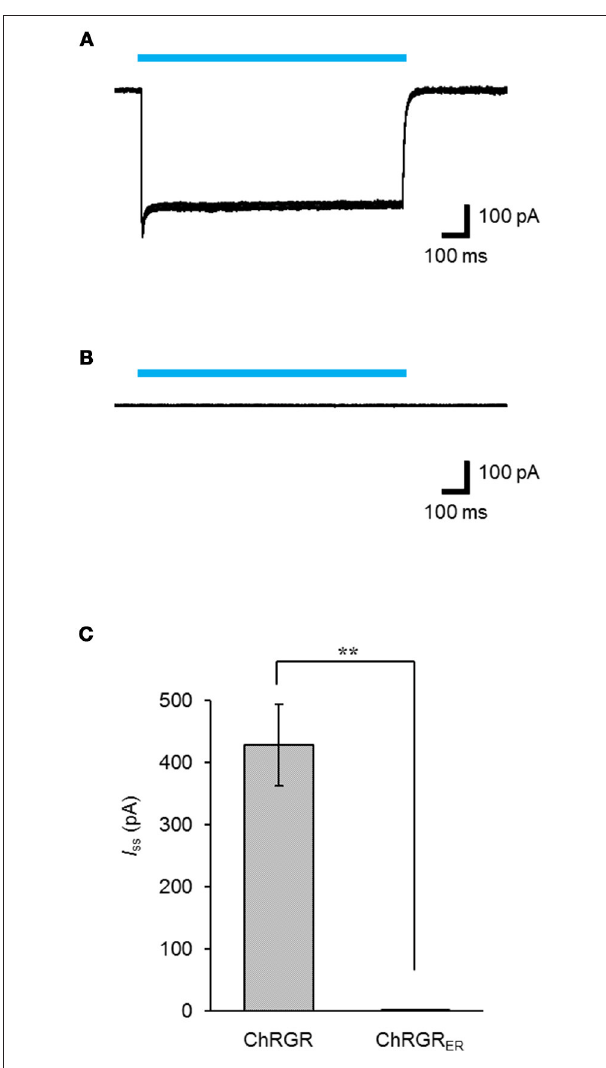
FIGURE 3 | Intracellular distribution of ChRGR ER . (A,B) Overlay of sample photocurrents recorded from either a ChRGR-expressing C2C12 cell (A) or ChRGR ER -expressing one (B) . Each cyan line shows the timing of the LED irradiation (505 ± 15nm, 1.6 mWmm − 2 ). (C) Summary of the I ss from the ChRGR- ( n = 6) and ChRGR ER -expressing C2C12 cells ( n = 7). ** p < 0.005, Mann-Whitney U -test.